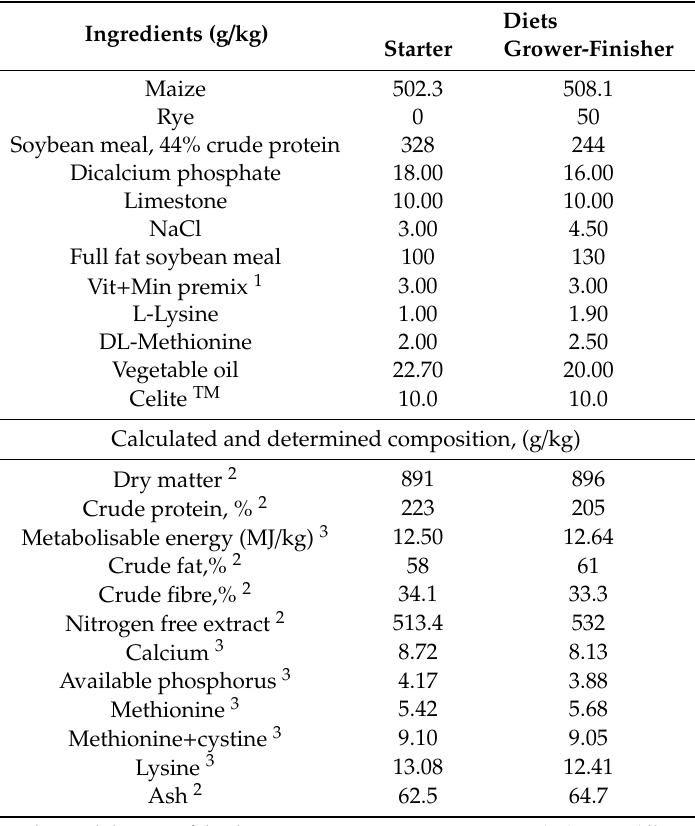
Table 1. Ingredients and chemical-nutritional composition of the experimental diets (as feed basis) during di ff erent experimental periods. Diets Ingredients (g / kg) Starter Maize Soybean meal, 44% crude